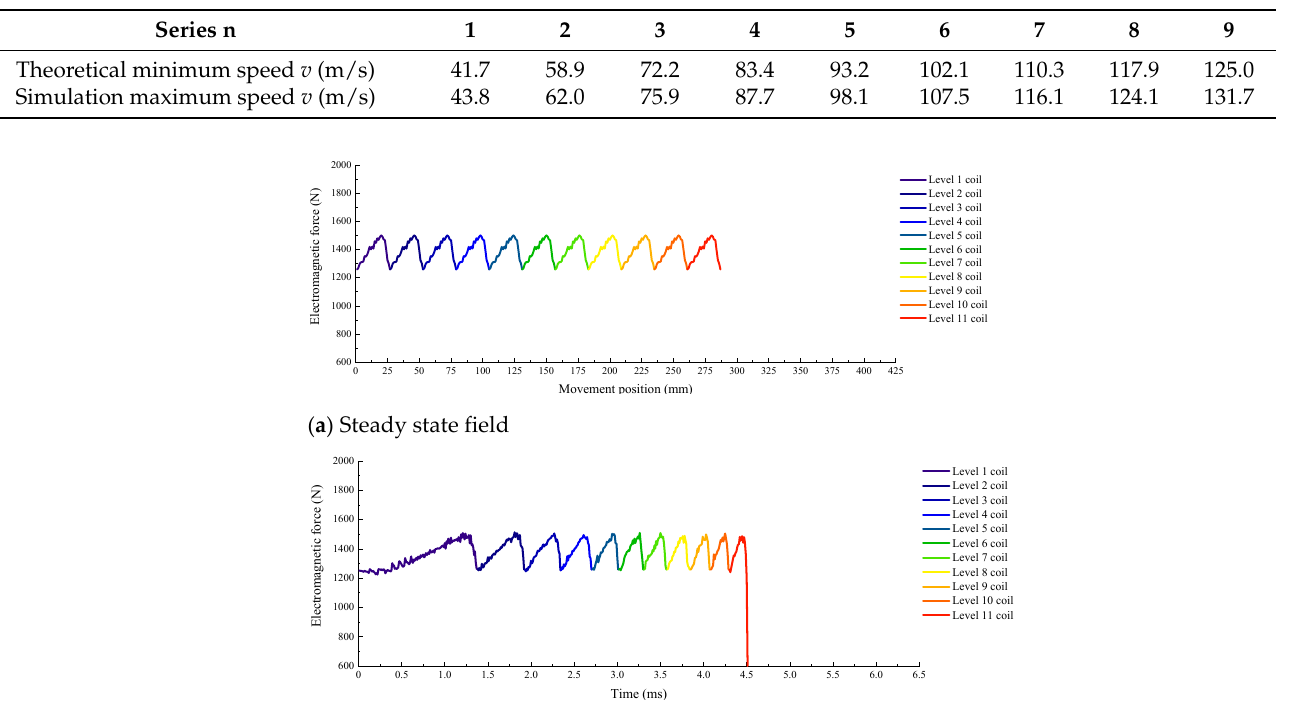
Figure 11. The speed diagram of the weft gripper. Table 2. Comparison table of theoretical speed and simulation speed.